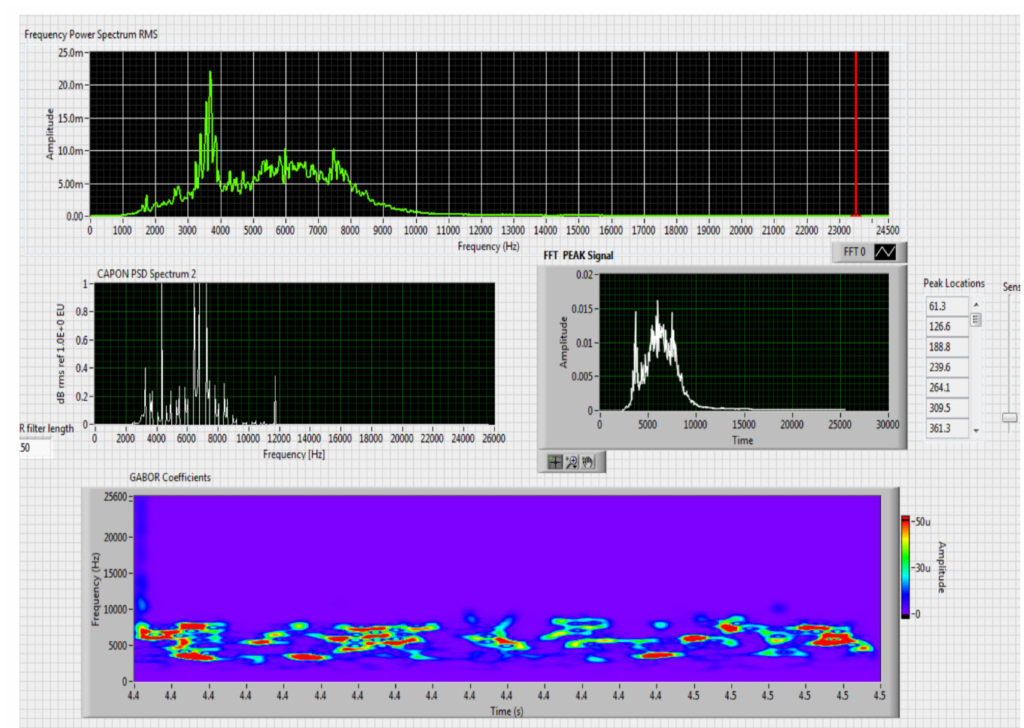
Figure 16. Results obtained for moving distance 100–380 m, altitude 60